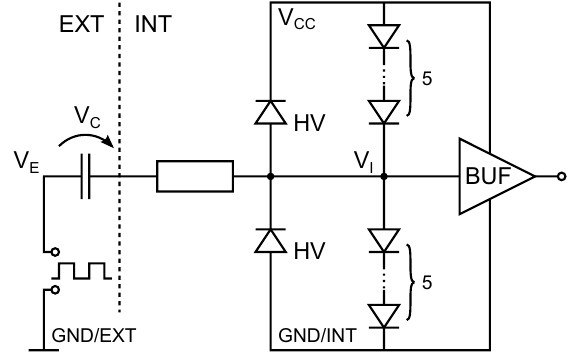
Figure 3. Schematic of DataRec .